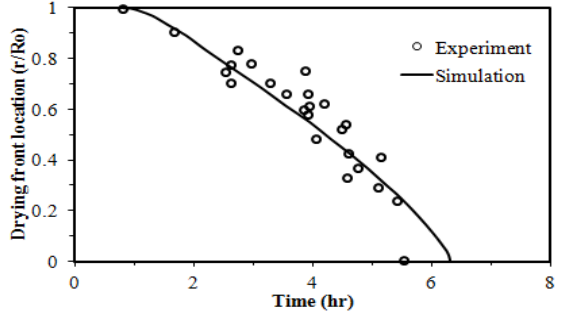
Figure 43. Drying front location as a function of time for cylindrical coal block heating experiments [80].